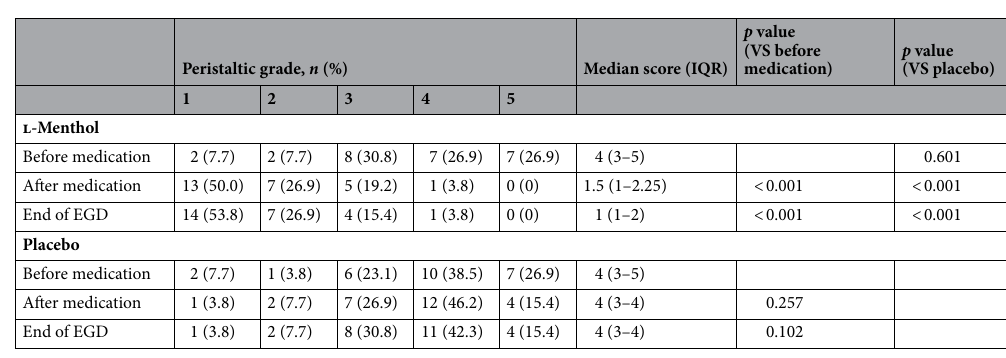
Table 2. Comparison of peristaltic grade in each period between the two groups. EGD esophagogastroduodenoscopy, IQR interquartile range, VS versus.